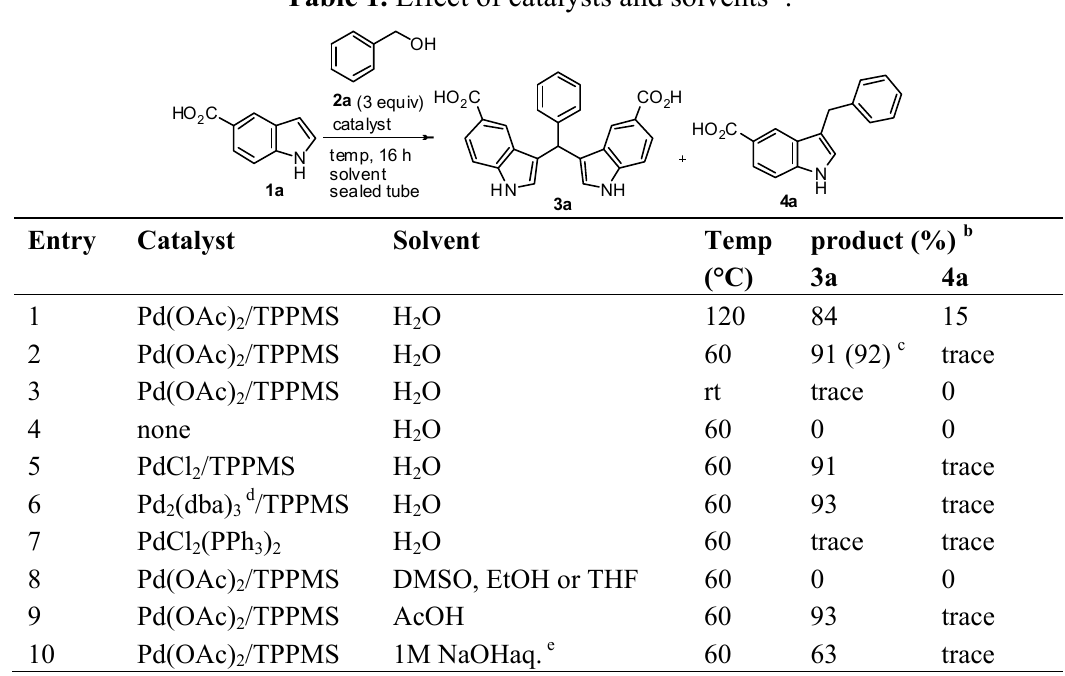
Table 1. Effect of catalysts and solvents a .